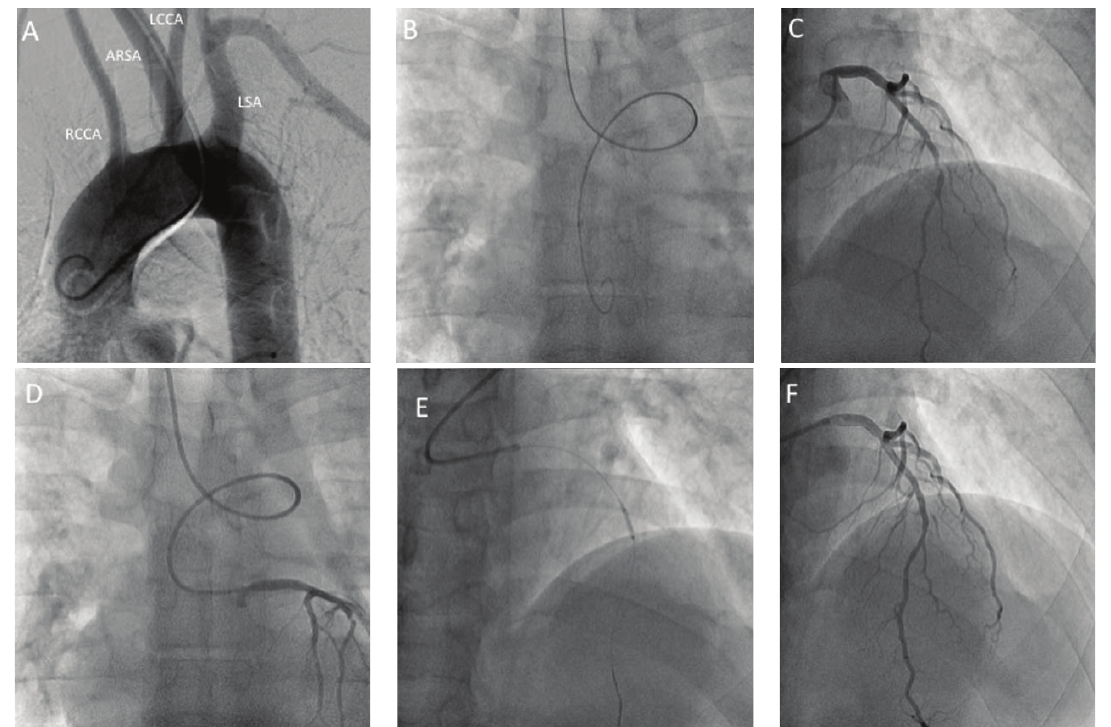
Figure 1: Angiographic images from Case 1: (A) aortogram of the ascending, transverse, and descending aorta demonstrating the ARSA; (B) anterior-posterior projection demonstrating the characteristic loop of ARSA with the guidewire in the descending aorta; (C) left anterior oblique cranial projection with Judkins left catheter engaging the left main demonstrating an 80% mid LAD coronary artery lesion; (D) the characteristic loop of ARSA; (E) ballooning of the LAD lesion; (F) final result. ARSA, aberrant right subclavian artery; LAD, left anterior descending; RCCA, right common carotid artery; LCCA, left common carotid; LSA, left subclavian